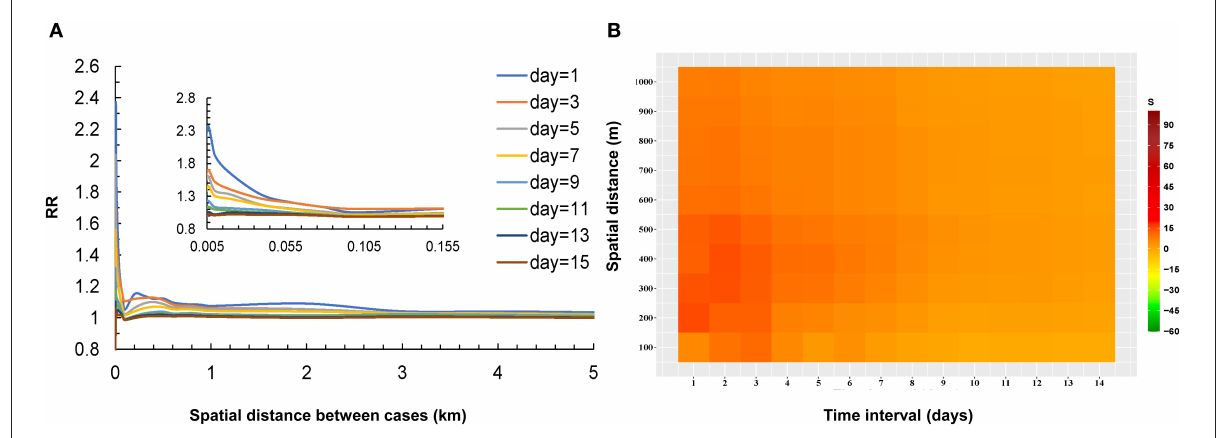
FIGURE3 Relationship between the risk of infection and distance for COVID-19 case pairs at different temporal thresholds in Guangzhou (A) , the strength of spatial-temporal clustering of all case pairs ( ≤ 1,000m and ≤ 14 d) (B)